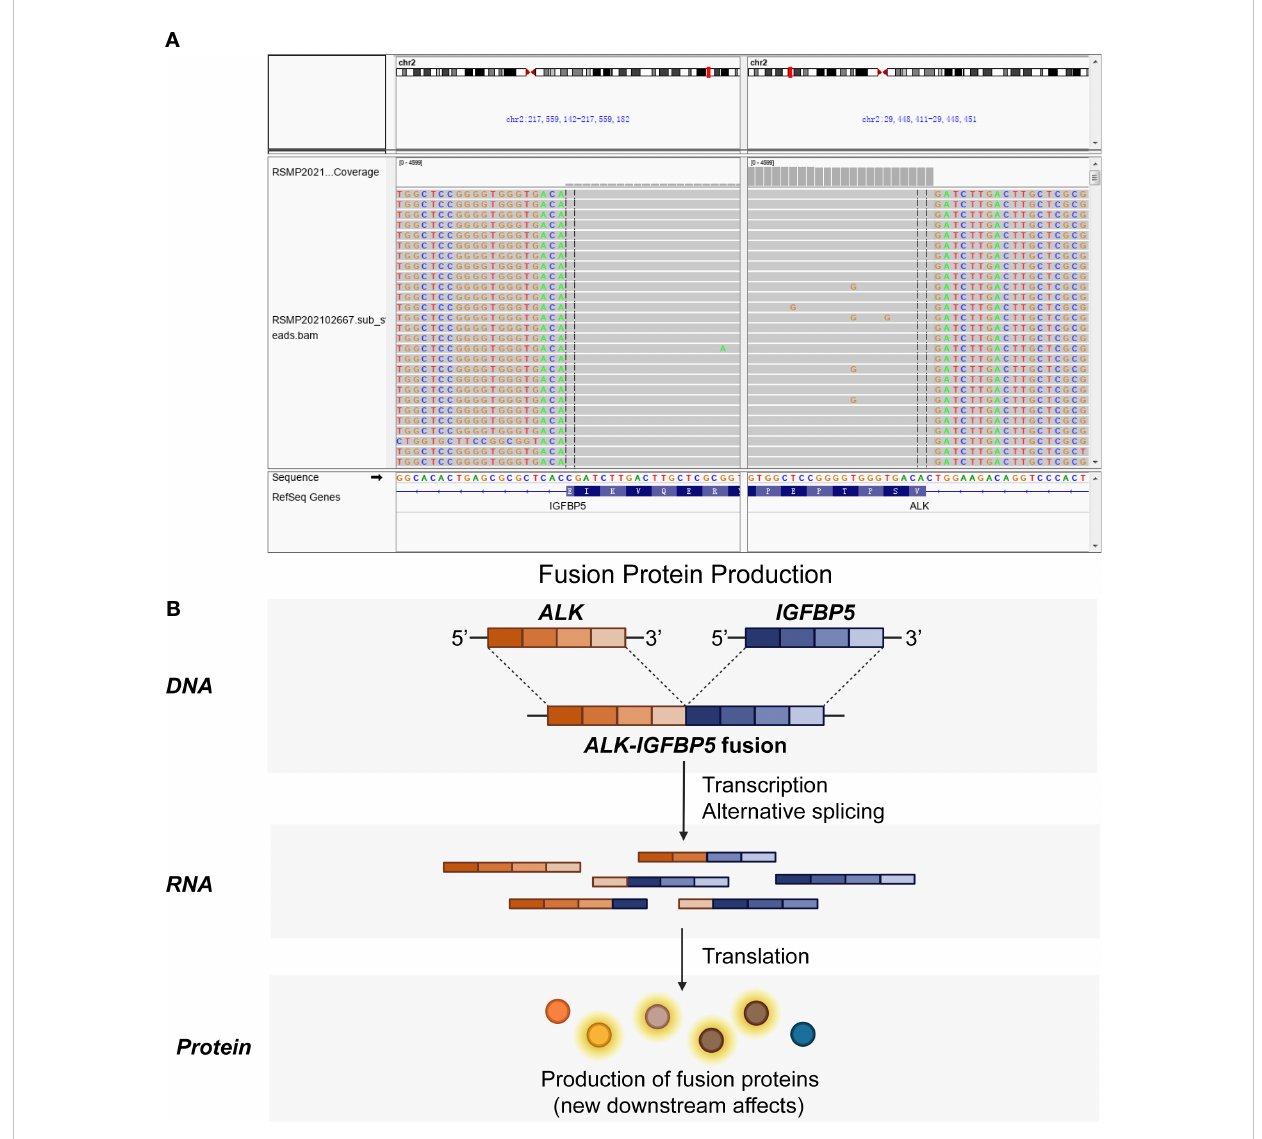
FIGURE 3 ALK-IGFBP5 fusion within the uterine IMT samples. The ALK-IGFBP5 gene fusion was identi fi ed by next-generation sequencing (A) and the working model (B) of the fusion. IMT, in fl ammatory myo fi broblastic